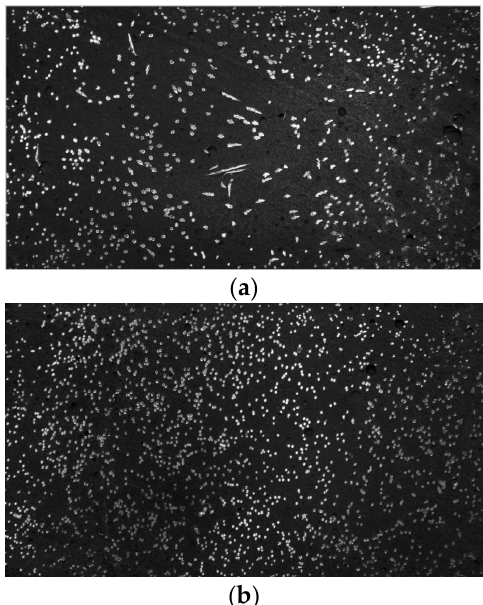
Figure 6. Images of the fiber distribution for the two different casting methods: ( a ) Method A; ( b ) Method B.